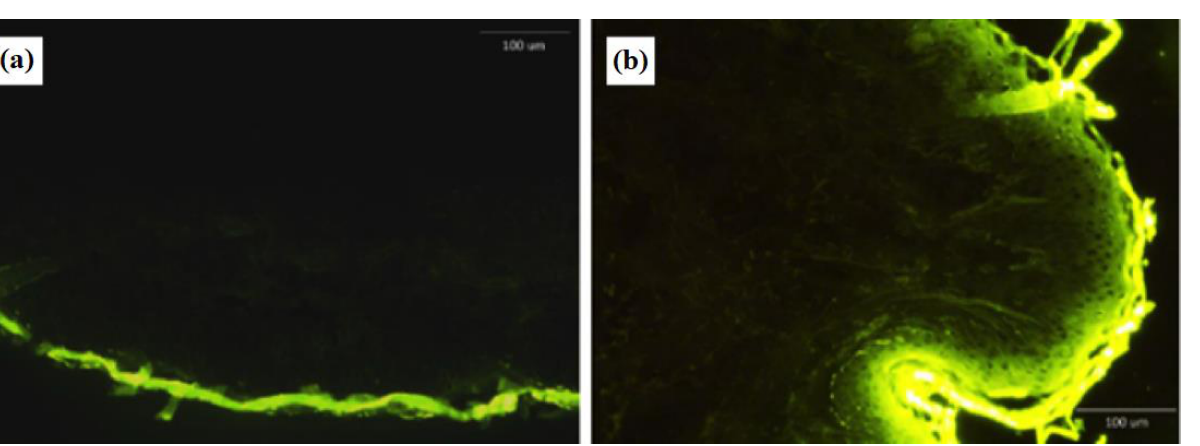
Figure 6. Sections of the full-thickness human skin after been treated with Fluorescein 5(6)-isothio- cyanate (FITC) solution ( a ) and FITC-loaded niosomes ( b ) after 12 h. isothiocyanate (FITC) solution ( a ) and FITC-loaded niosomes ( b ) after 12